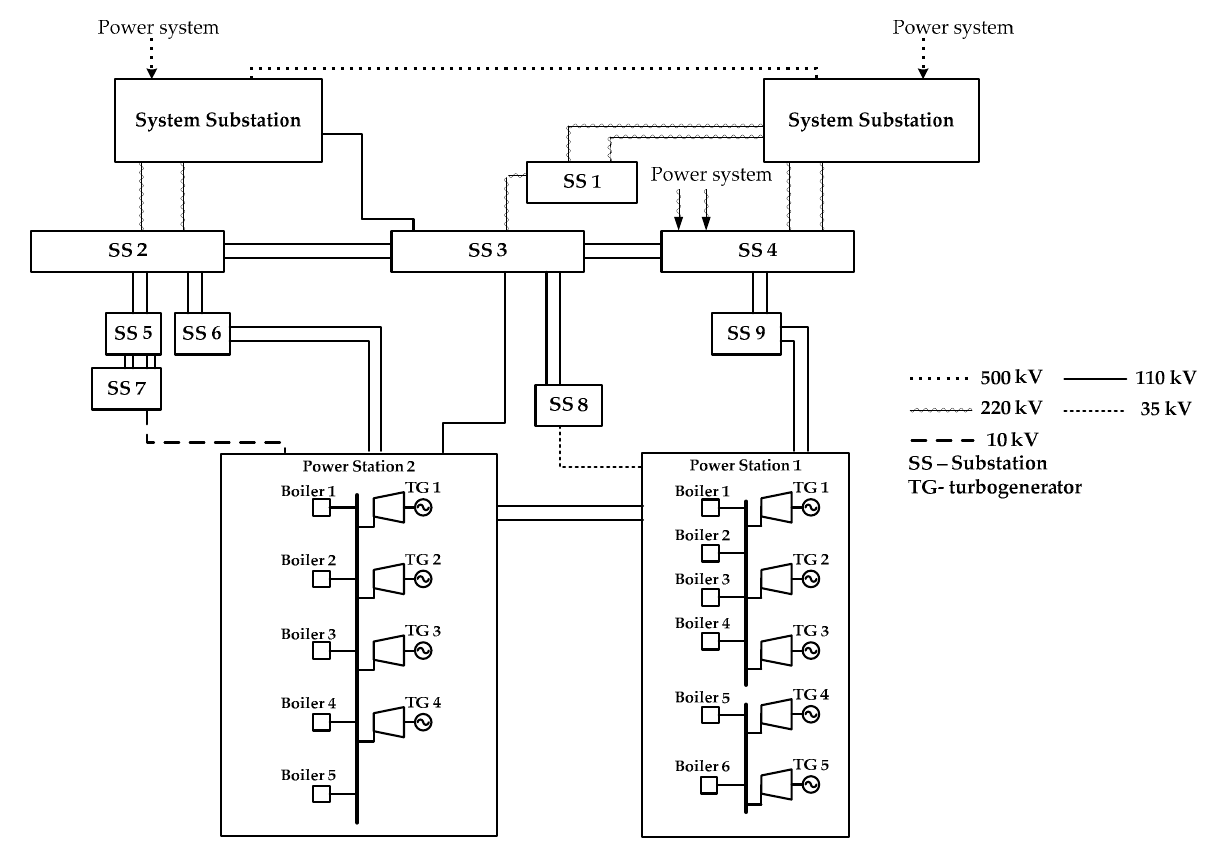
Figure 3. Structural diagram of the power supply system with its own and external sources.